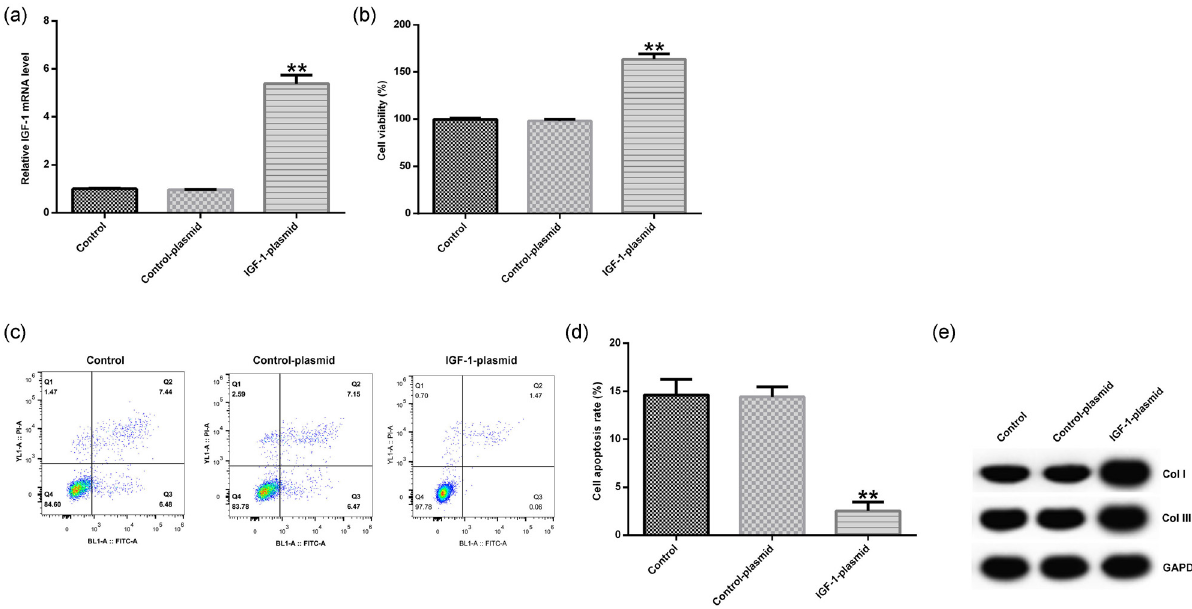
Figure 3: The e ff ect of IGF - 1 plasmid on the cell viability, cell apoptosis, and the protein expression of Col I and Col III in HVFs from POP patients. Control plasmid and IGF - 1 plasmid were transfected into HVFs and then MTT, FCM, and Western blotting assay were used to detect the cell viability, cell apoptosis, and the protein expression of Col I and Col III. ( a ) The e ff ect of IGF - 1 plasmid on IGF - 1 mRNA expression in HVFs. ( b ) The e ff ect of IGF - 1 plasmid on the cell viability of HVFs. ( c and d ) The e ff ect of IGF - 1 plasmid on the cell apoptosis of HVFs. ( e ) The e ff ect of IGF - 1 plasmid on the protein expression of Col I and Col III in HVFs. Data were reported as mean ± SD. ** p < 0.01 vs control